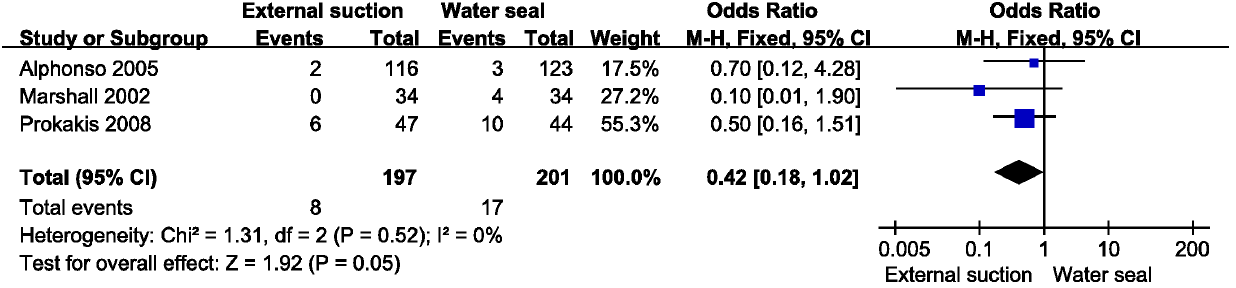
Figure 6. Meta-analysis of external suction versus water seal on the incidence of pneumothorax. M-H, Mantel-Haenszel method. Events means patient with postoperative